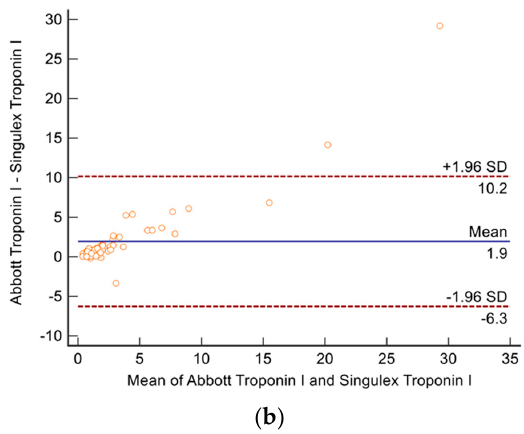
Figure 1. Correlation between Singulex Troponin I versus Abbot Troponin I. ( a ) Regression between Singulex Troponin I versus Abbott Troponin I. Spearman coefficient R 2 = 0.87, y = − 0.6106 + 2.1960 x , p < 0.0001. ( b ) Bland Altman plot comparing Singulex and Abbott Troponins.